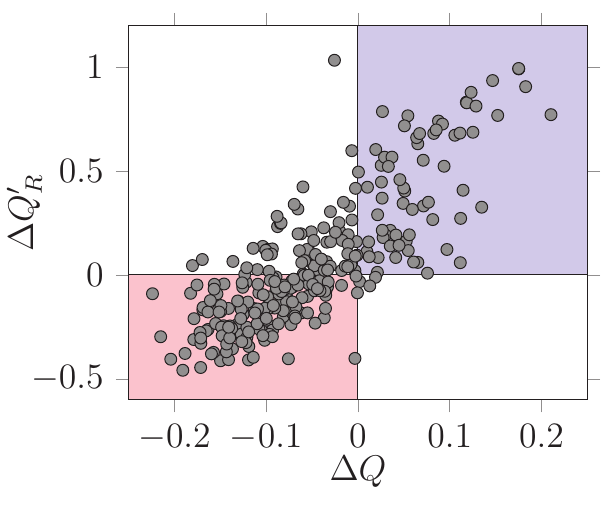
Figure 4. Linear relationship between the deviation from random expectation in Q and Q ′ . Networks in the red area are R detected as being less modular than expected both by Q ′ and Q , R while networks in the blue area are detected as being more modular. Although the agreement between the two measures is good (see main text for statistics), some networks are detected as having a , despite a lower than higher than expected realized modularity Q ′ R expected modularity Q. Each dot correspond to a